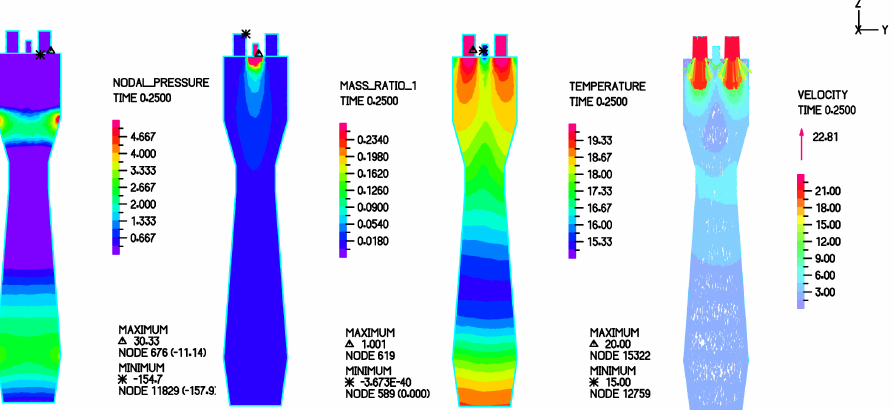
Figure 9. ADINA modeling results for three-dimensional turbulent flow model with heat transfer and mass transfer.